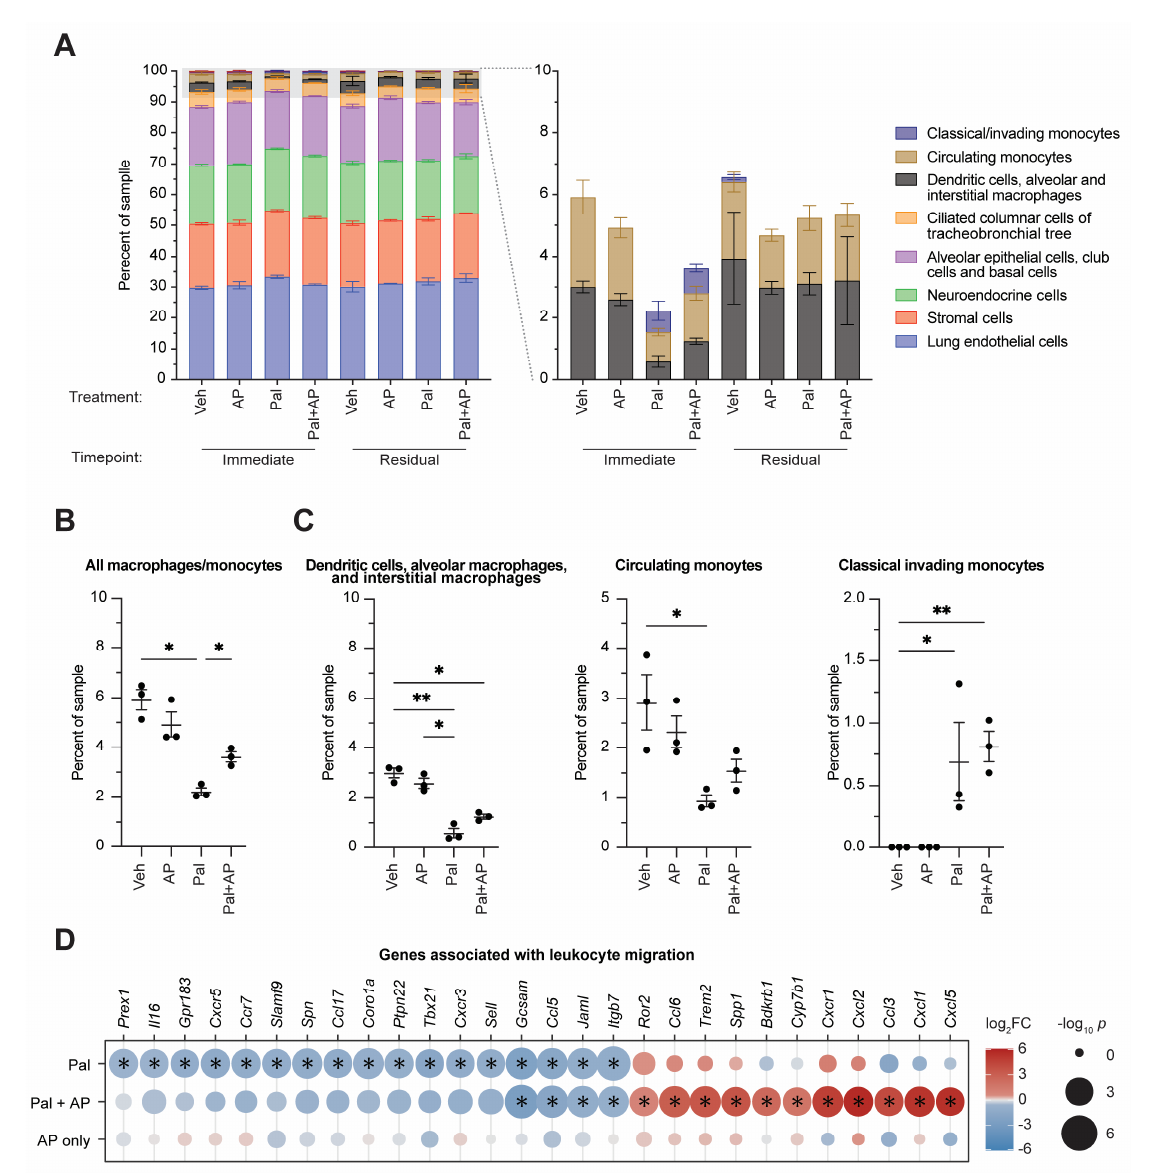
Figure 3. Palbociclib and senescence reversal alter macrophage and monocyte composition in normal mouse lungs. ( A ) CIBERSORTx analysis of mRNA from lungs in di ff erent treatment groups treated with vehicle (Veh), AP20187 (AP), palbociclib (Pal), or palbociclib and AP combination (Pal + AP) collected immediately after 10 days of treatment (“Immediate E ff ect” cohort) or after 10 days of treatment plus 14 days of palbociclib holiday or continued AP (“Residual E ff ect” cohort). ( B ) Sum of macrophage and monocyte cell types as a percentage of each sample. ( C ) Macrophage or monocyte subtypes as a percentage of each sample. Zeros indicate measurements that were below detection threshold. ( B , C ) * p < 0.05, ** p < 0.01 by one-way ANOVA with Tukey’s multiple comparisons test. ( D ) Di ff erentially expressed genes in treated ATTAC lungs from the gene ontology annotation “leukocyte migration” retrieved from AmiGO under accession number GO:0050900. Color indicates di ff erential expression; size indicates signi fi cance level. * di ff erential gene expression surpassing statistical signi fi cance threshold of absolute value of log 2 fold change > log 2 (1.5) and p < 10 − 3 . Di ff erentially expressed genes graphed reached statistical signi fi cance threshold or were excluded.